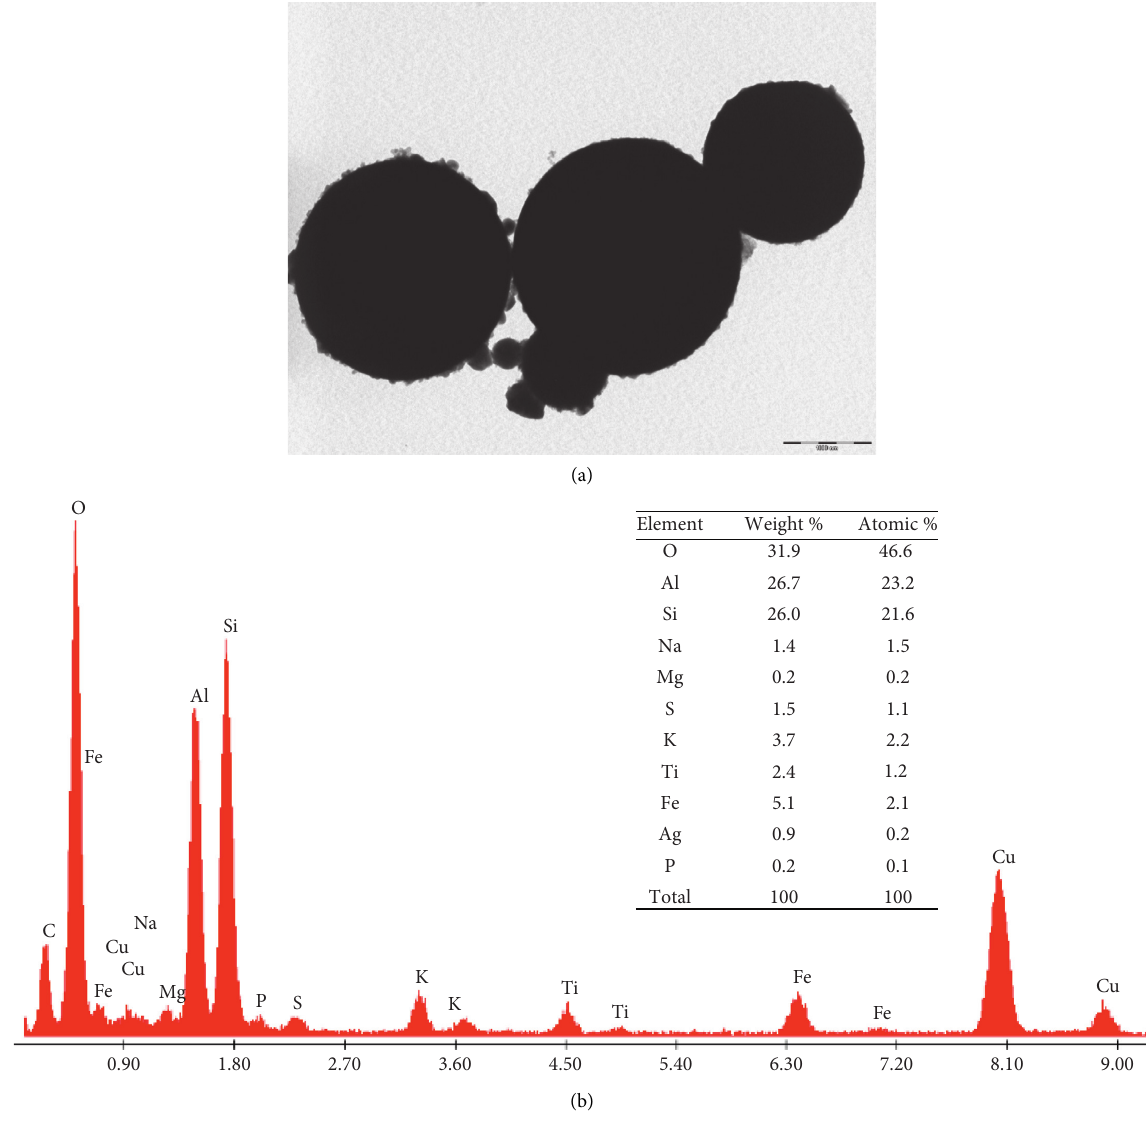
Figure 1: TEM image (a) and EDX (b) of fly